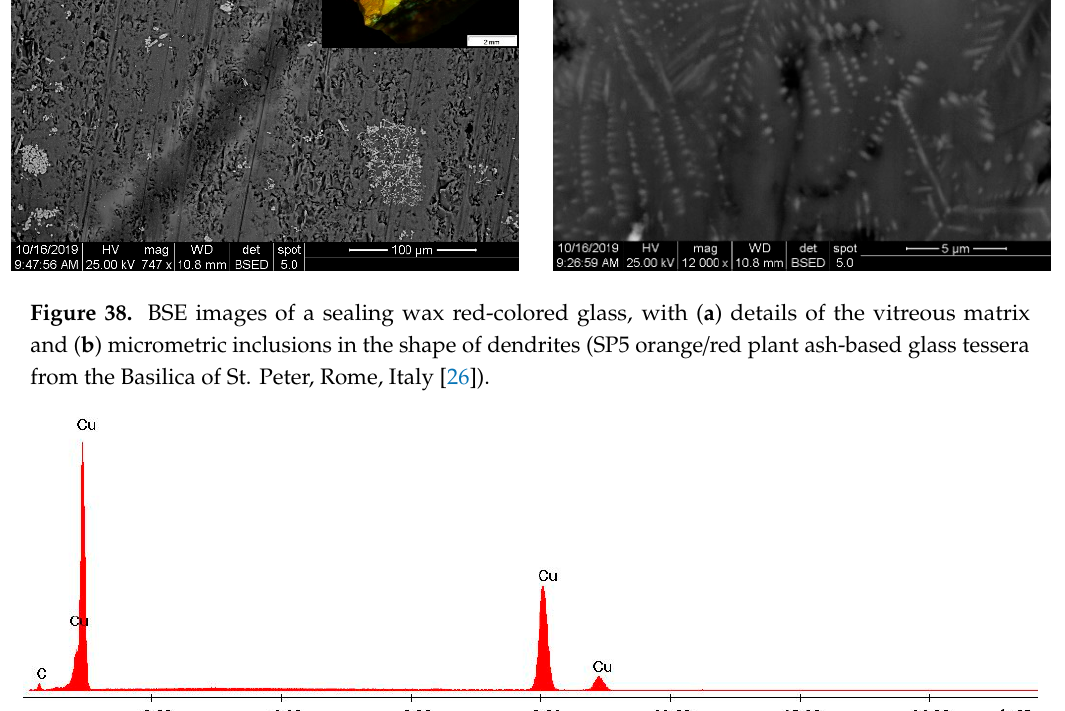
Figure 39. EDS spectrum acquired on the rounded inclusions, exclusively made of Cu (SP5 orange/red plant ash-based glass tessera from the Basilica of St. Peter, Rome, Italy [26]).